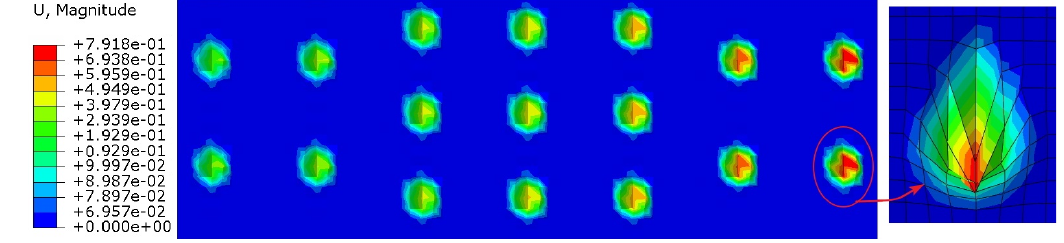
Figure 14. The strain distribution of casing wall (before optimization).